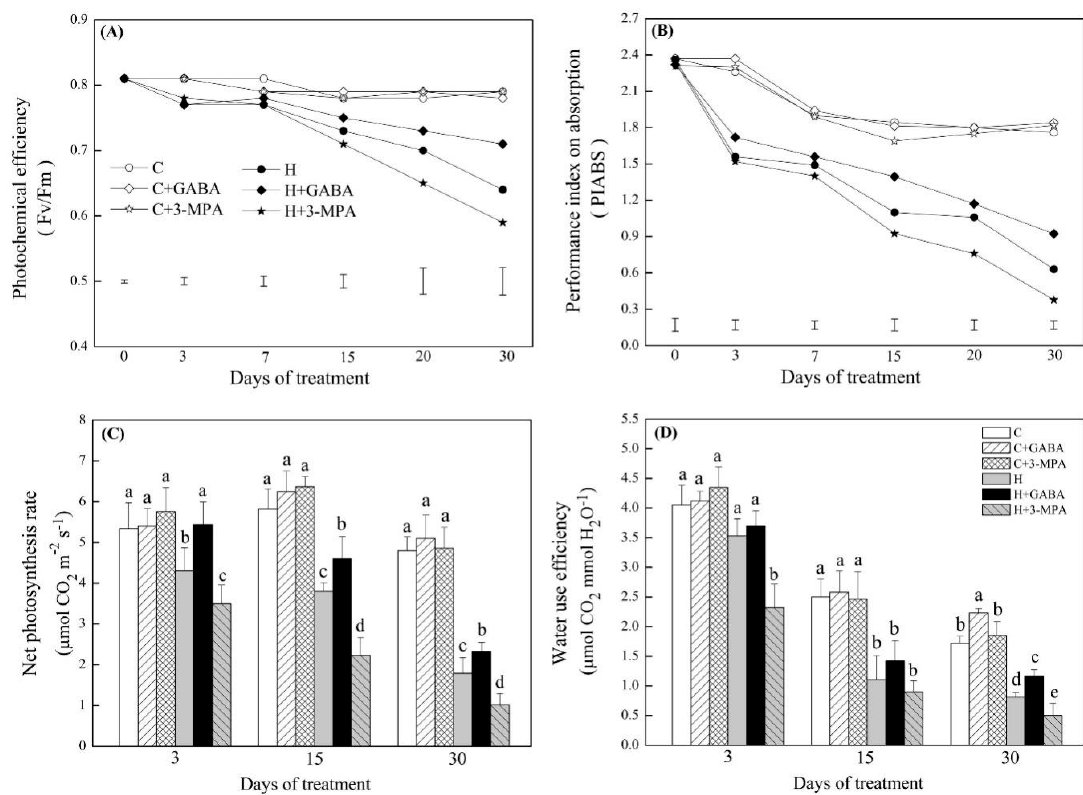
Figure 4. Effects of γ -aminobutyric acid (GABA) and 3-mercaptopropionic acid (3-MPA) on ( A ) photochemical efficiency (Fv/Fm), ( B ) performance index on absorption (PIABS), ( C ) net photosynthesis rate (Pn), and ( D ) water use efficiency (WUE) in leaf of creeping bentgrass during 30 days of 23/18 (normal condition) or 38/33 °C (heat stress). Vertical bars below curves represent least significance difference (LSD) values at a given day of treatment ( p ≤ 0.05); vertical bars above columns indicate ±standard error (SE) of means ( n = 4) and different letters above columns indicate significant differences ( p ≤ 0.05). C: control; C+GABA: control+GABA; C+3-MPA: control+3-MPA; H: heat; H+GABA: heat + GABA; H+3-MPA: heat+3-MPA.